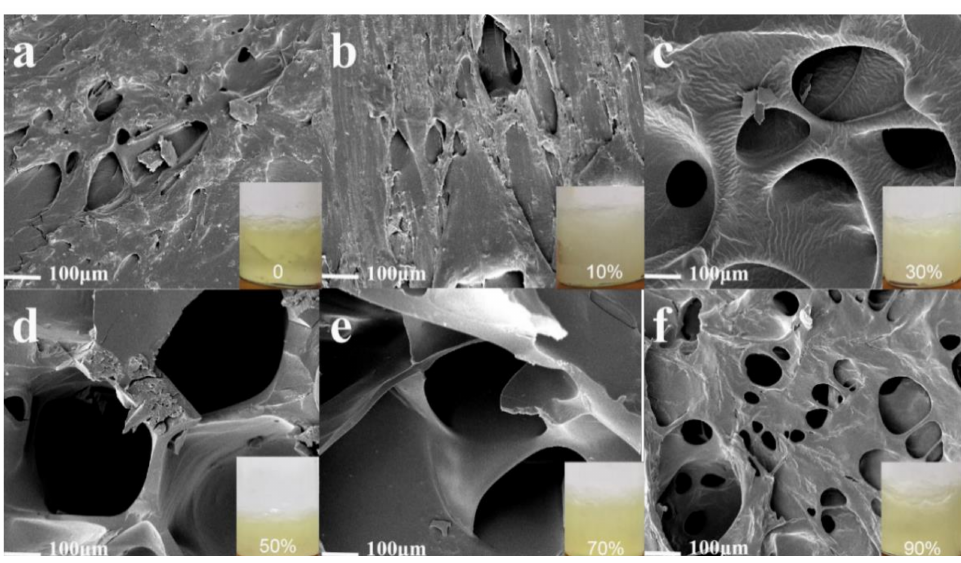
Figure 6. ( a ) SEM image of starch gel with 0% amylopectin content/( b ) SEM image of starch gel with 10% amylopectin content/( c ) SEM image of starch gel with 30% amylopectin content/( d ) SEM image of starch gel with 50% amylopectin content/( e ) SEM image of starch gel with 70% amylopectin content/( f ) SEM image of starch gel with 90% amylopectin